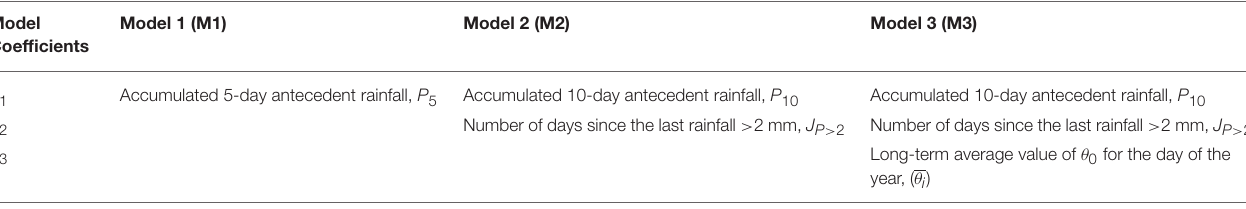
TABLE 1 | A summary of the different models that were evaluated. Model Coefficients